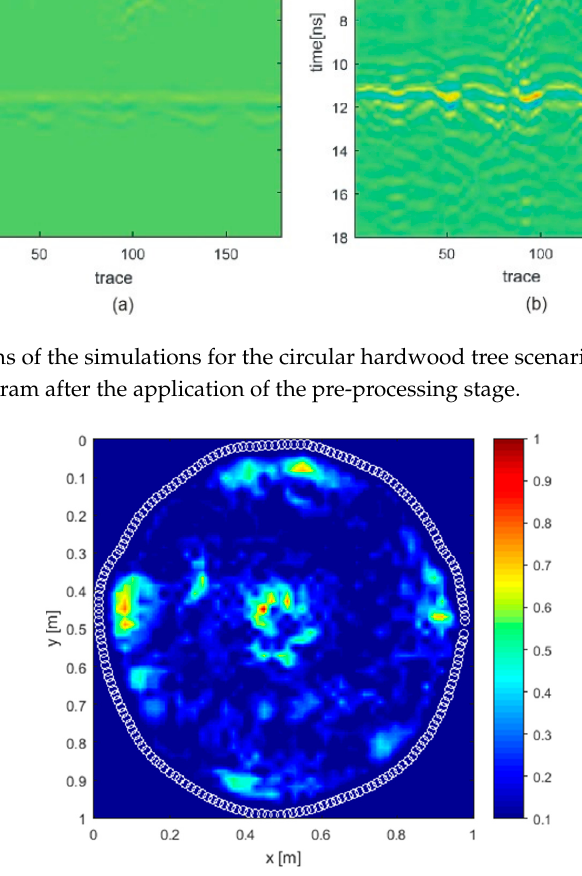
Figure 10. Tomographic reconstruction of the circular hardwood tree scenario with time-gating up to 2 ns. The circles in white solid line along the trunk perimeter represent the positions of the measurement points.